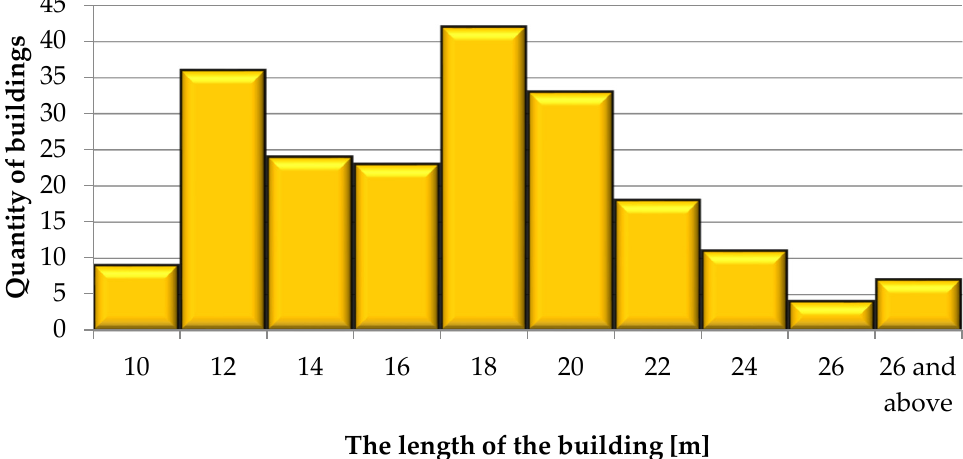
Figure 7. Distribution of data for the variable relating to the length of the buildings [m].